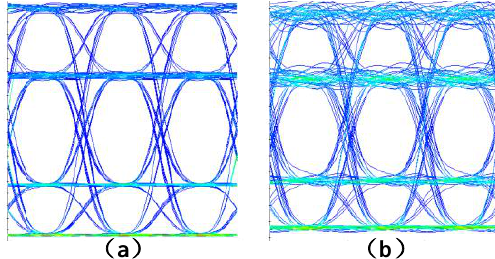
Fig. 5. (a) The measured eye diagram at the BTB case; (b) The measured eye diagram after